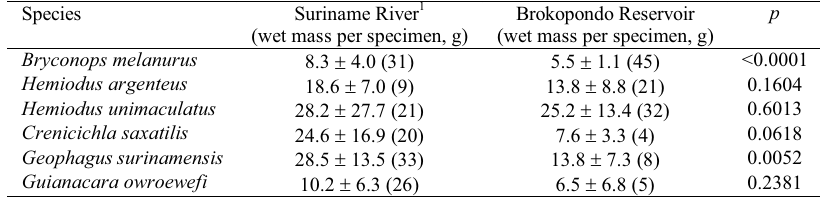
Table 5. Comparison of average wet mass per specimen (mean ± SD; g) of some dominant fish species in samples of Suriname River (1963-1964) and Brokopondo Reservoir (2002-2005). Number of samples in parentheses. Results of t -test are given. Measurements of wet mass of Suriname River fishes were taken 40 years after the specimens had been placed in ethanol, which is known to cause significant shrinkage of tissues; these values should be taken as minimum values 1